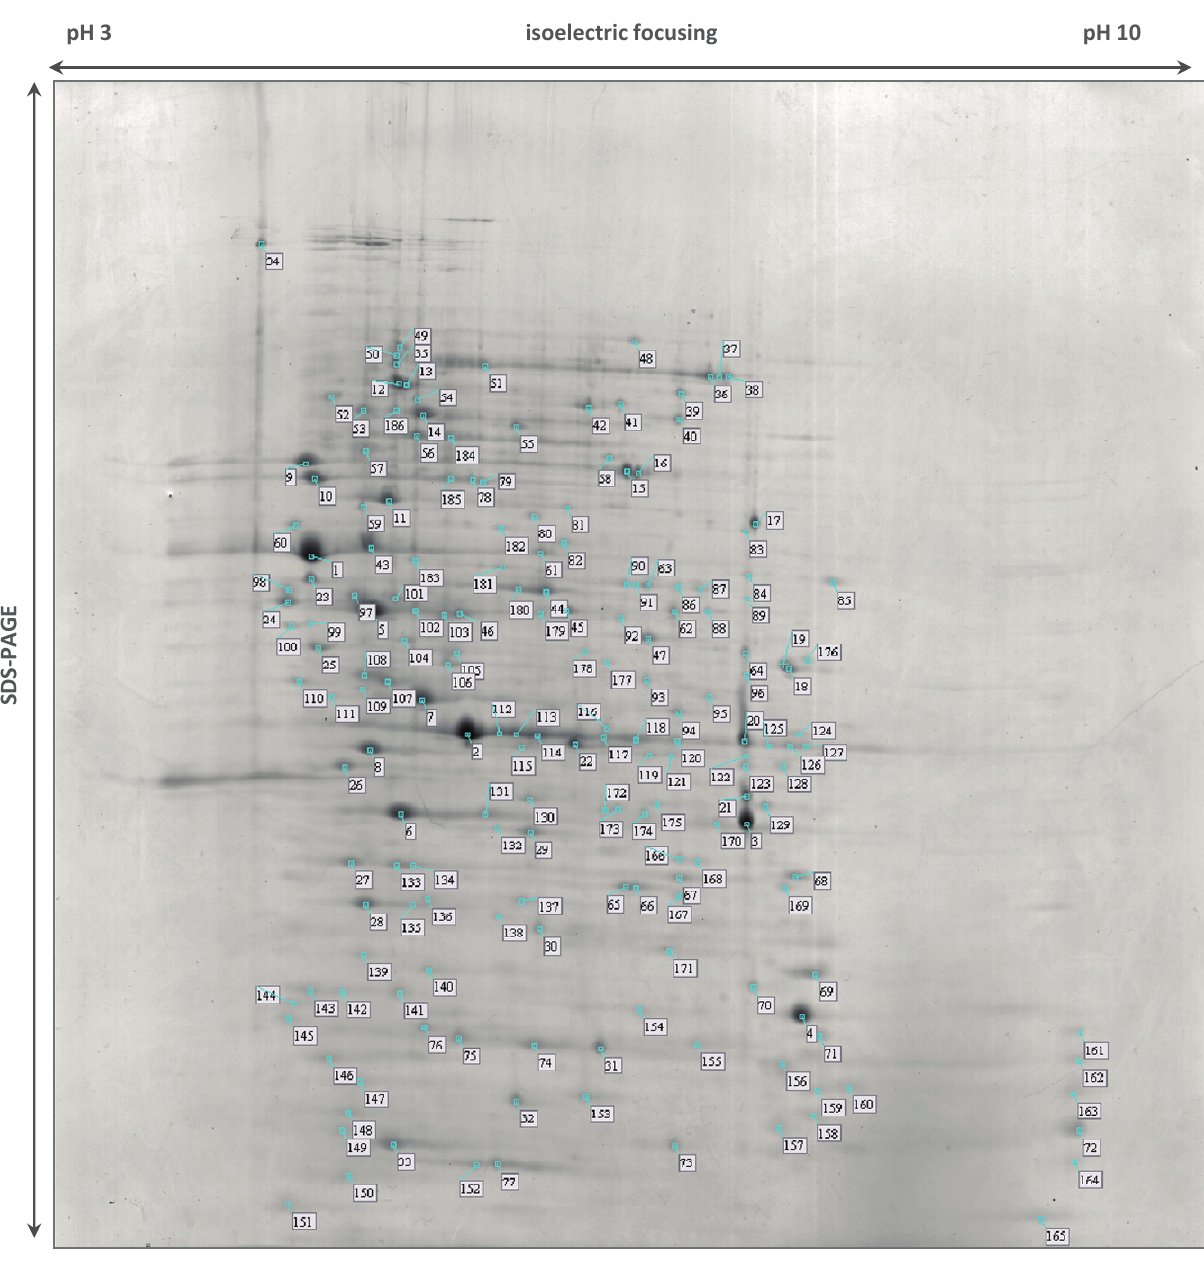
Figure 1. Stained 2-DE (two dimensional gel electrophoresis) gel of total proteins of Salmonella Typhimurium Se20 (phage type DT104B) using IPG (Immobiline™ pH Gradient) strips pH 3–10 NL (non-linear) for the first dimension. Numbered spots were excised for analysis by in-gel digestion and MALDI-TOF MS (matrix-assisted laser desorption/ionization mass spectrometry) identification, described in Table